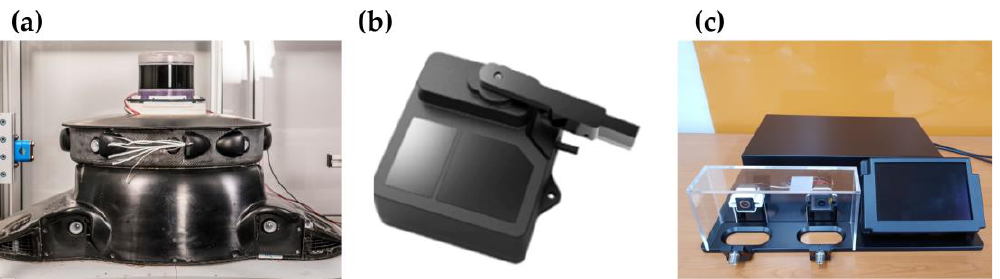
Figure 1. Type of sensor cleaning ( a ) Air-type cleaning system; ( b ) wiper-type cleaning system; ( c ) electric-type (piezo, electrowetting) cleaning system.